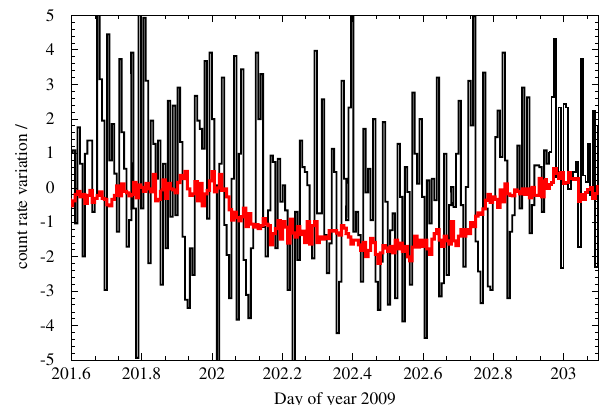
Fig. 3. Variation of 10 min averaged count rates of the single detector rate G (red curve) and the integral channel (black curve) during the passage of a Stealth CME (Heber et al., 2015). For details